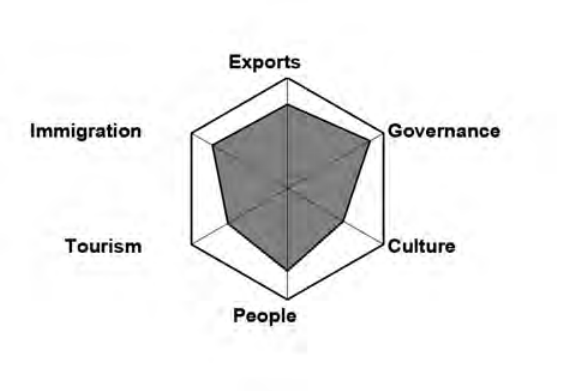
Figure 6. Anholt GFK six Path aways Chart